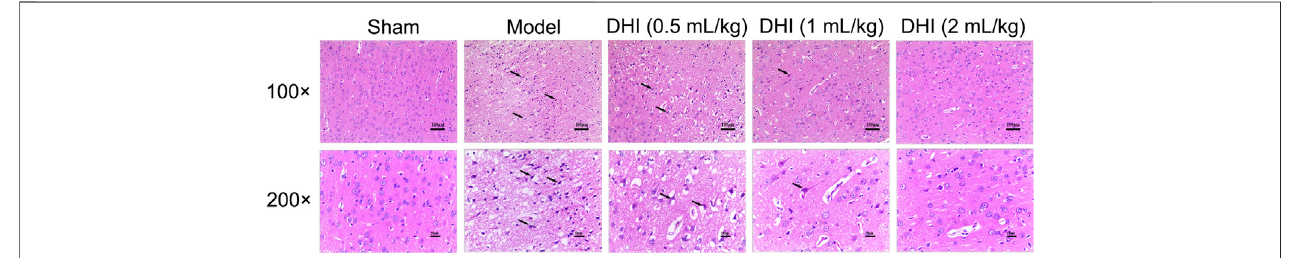
FIGURE 3 | Effects of DHI on the pathological changes in the penumbra of ischemic ipsilateral parietal cortex at 24 h after CIRI in rats. Representative images of H&E staining at 100 × and 200 × magni fi cation, and the black arrows indicate necrotic cells.